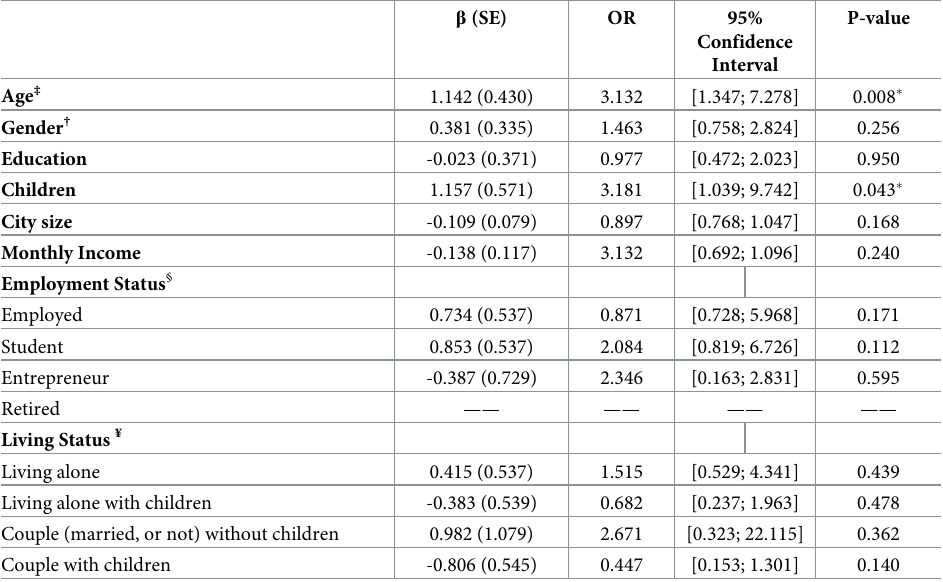
Table 4. Logistic regression analysis for COVID-19